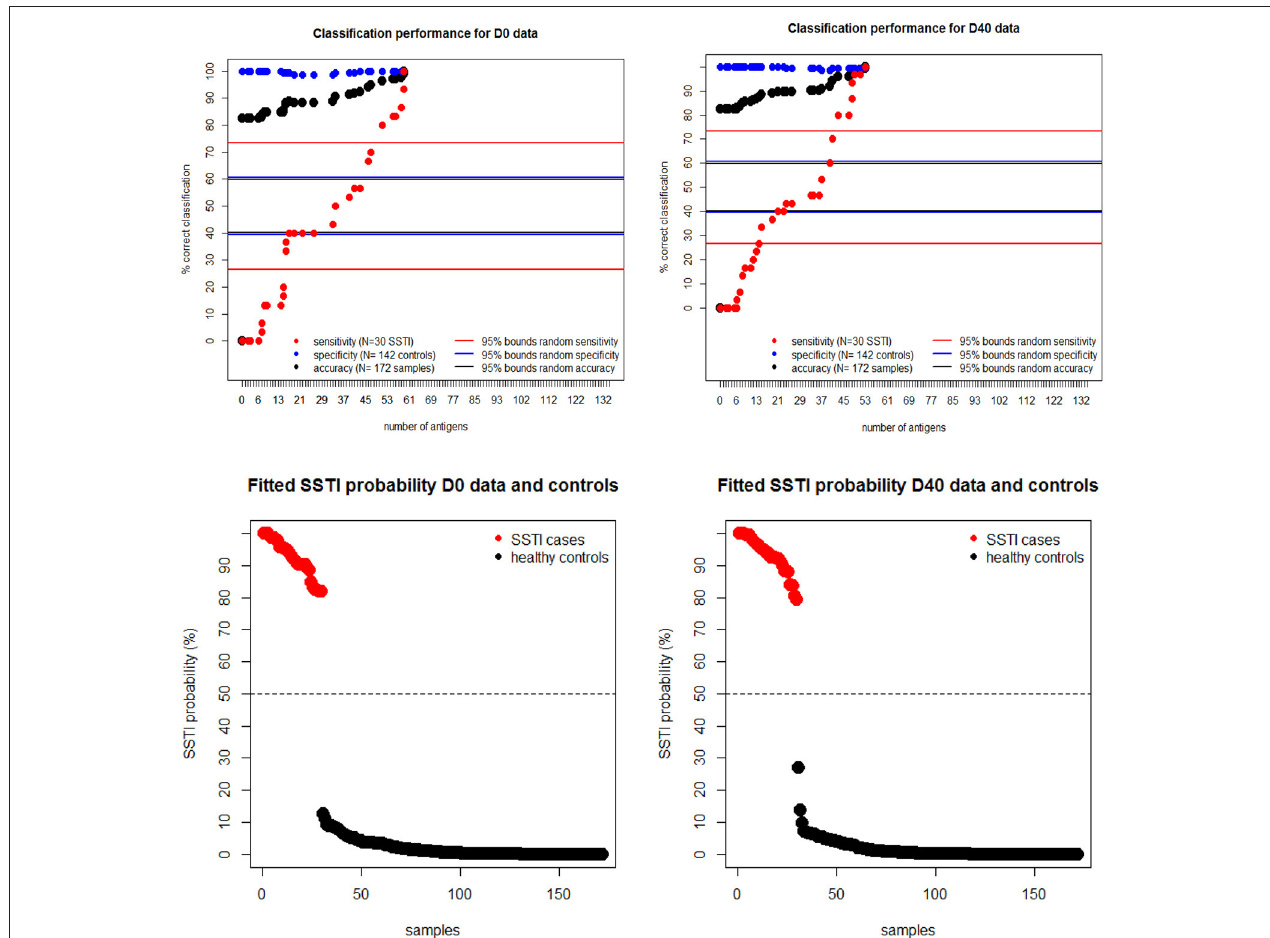
FIGURE 4 | Upper panels: regression sensitivity (red dots) at D0 (left) and D40 (Right) improved monotonically in the size of the antigen set selected by the penalized multiple logistic regression while specificity (blue dots) was roughly constant. The horizontal lines show the 95% probability intervals of the random classifier (40–61% for accuracy in black, 27–73% for sensitivity in red and 40–62% for specificity in blue lines). Bottom panels: the smallest fitted S. aureus SSTI probability among SSTI cases was 78% and the highest SSTI probability among the controls was 29%, showing a clear separation of the fitted infection status on the basis of the measured IgG